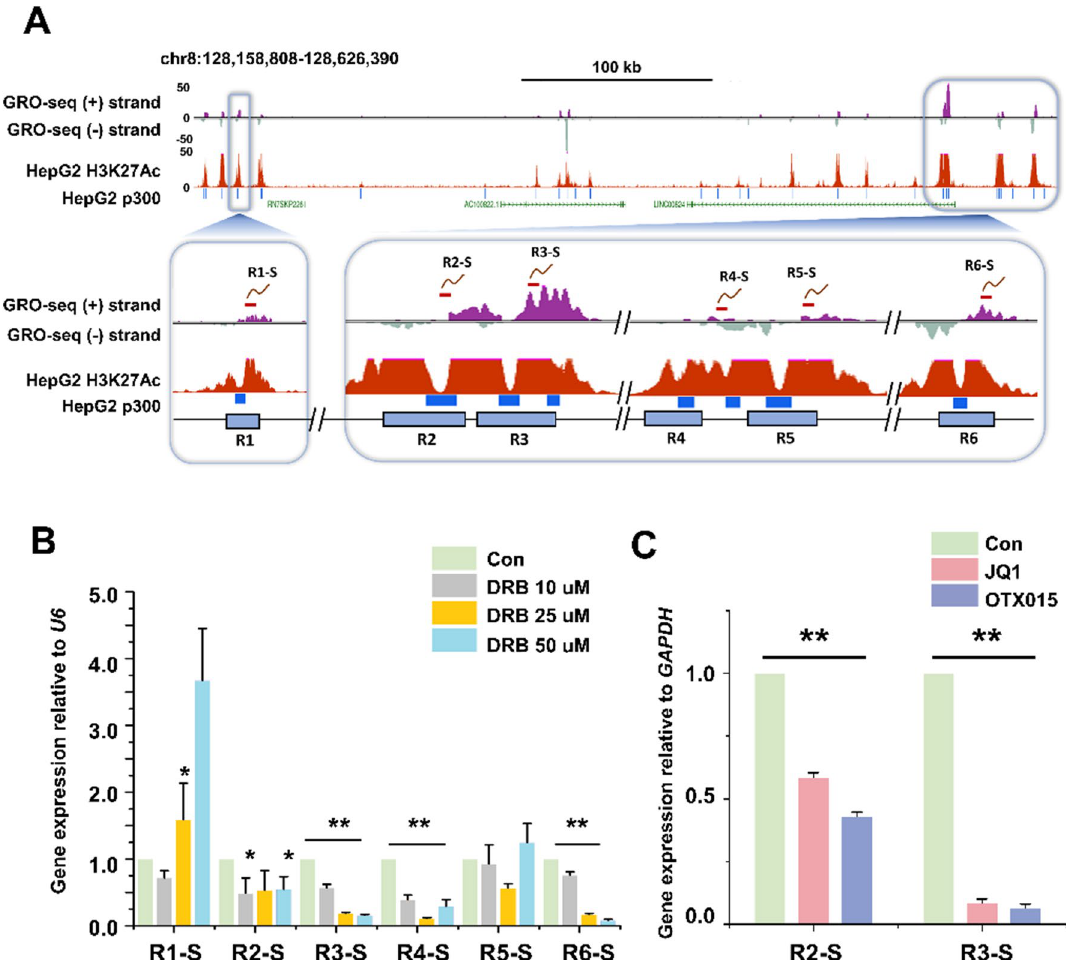
Figure 3. The eRNA expression by MYC enhancer regions in HepG2 cells. ( A ) USCS genome browser view of the GRO-seq peak, H3K27ac enrichment, and p300 binding sites along the MYC locus of HepG2 cells. An enlarged display of GRO-seq peak (+ strand and − strand) and H3K27ac enriched reads aligned to the putative enhancer regions (GRCh38/Chr 8: 128,158,808–128,626,390). eRNA primers were designed for six putative enhancer regions (R1, R2, R3, R4, R5, and R6). R1-S, R2-S, etc., stand for the sense strand eRNAs of the R1, R2, etc. regions. The red line above the GRO-seq (+) strand indicates target eRNA. ( B ) qRT-PCR of eRNA transcription levels in HepG2 cells treated with different concentrations of DRB (10 µM, 25 µM, and 50 µM; 6 h). ( C ) qRT-PCR of eRNA transcription levels in BET inhibitor-treated HepG2 cells (5 µM, 24 h). The values are the mean ± SD from triplicate well measurements. * p < 0.05 and ** p <